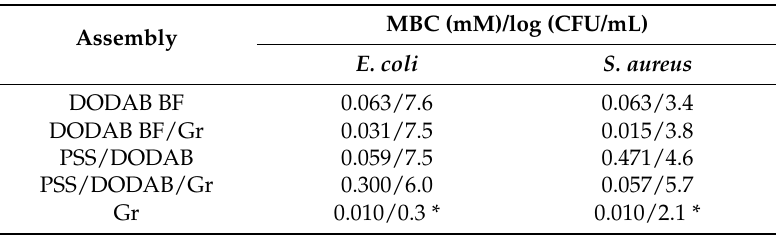
Table 2. MBC, in mM, and maximal reduction of cell viability, in log (CFU/mL), for DODAB in different assemblies against E. coli and S. aureus